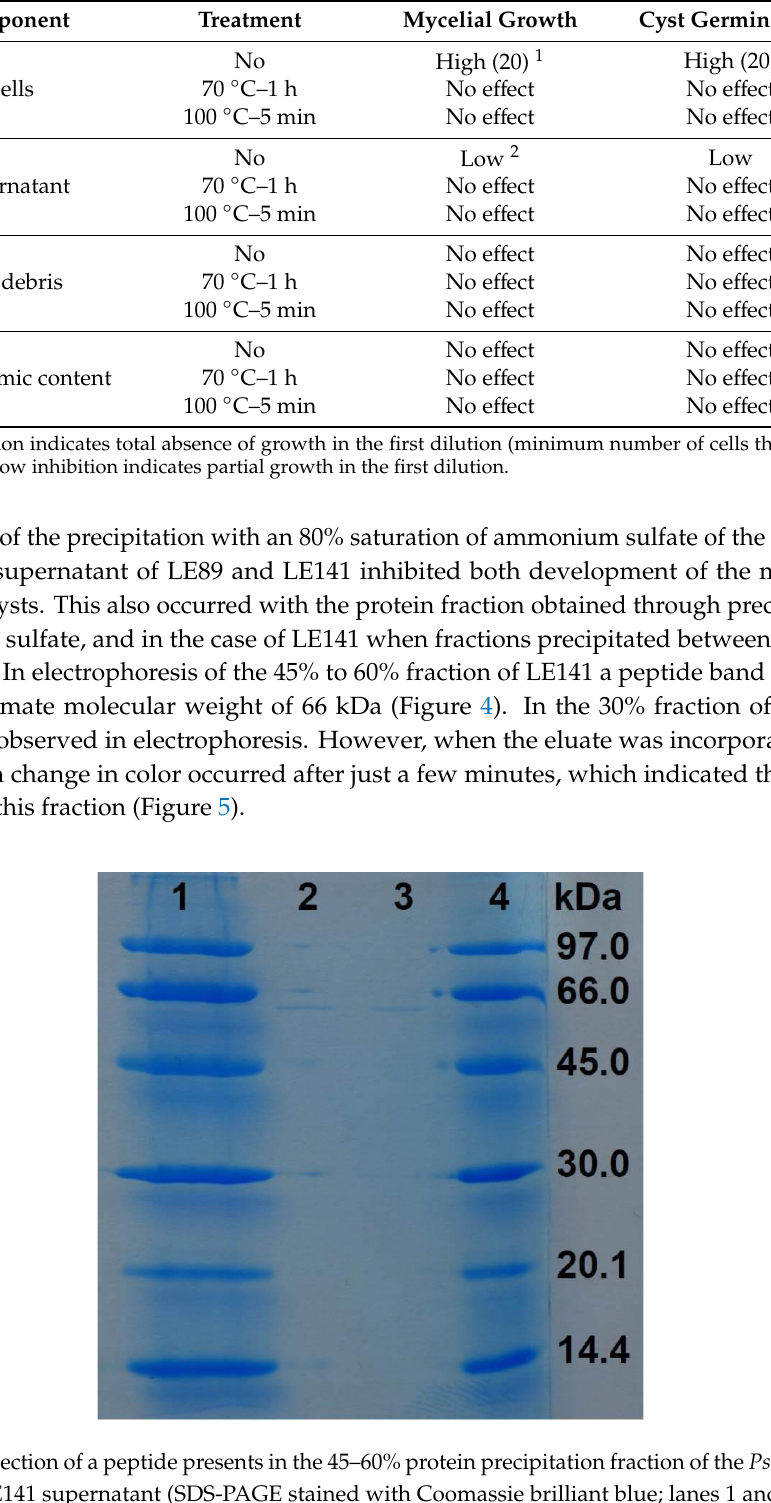
Table 4. Inhibitory activity of the cells, supernatant, cell debris, and cytoplasmic content of Psudomonas fluorescens LE141 (without heat treatment, treatment at 70 °C – 1 h or treatment at 100 °C – 5 min) on mycelial growth and cysts germination of Saprolegnia parasitica .